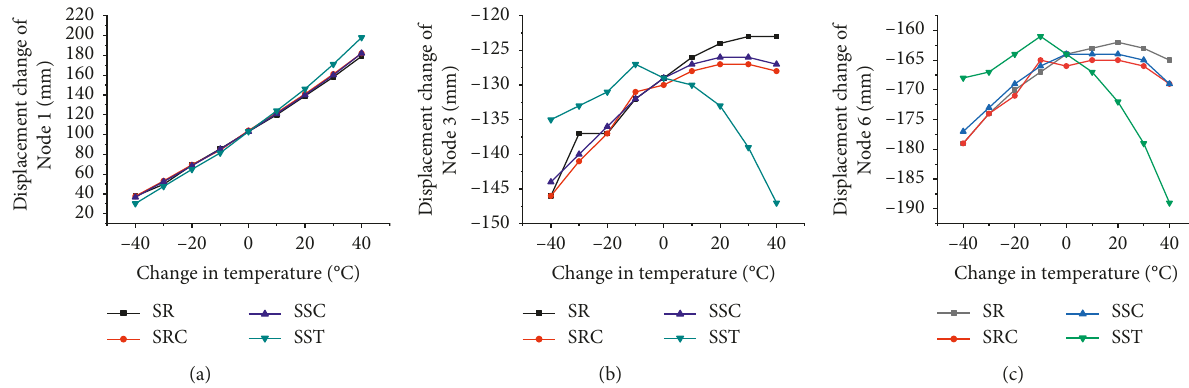
Figure 9: Relationship between the vertical displacement of nodes and the temperature in the half-span load distribution. Displacement of (a) Node 1, (b) Node 3, and (c) Node 6 with varying temperature.